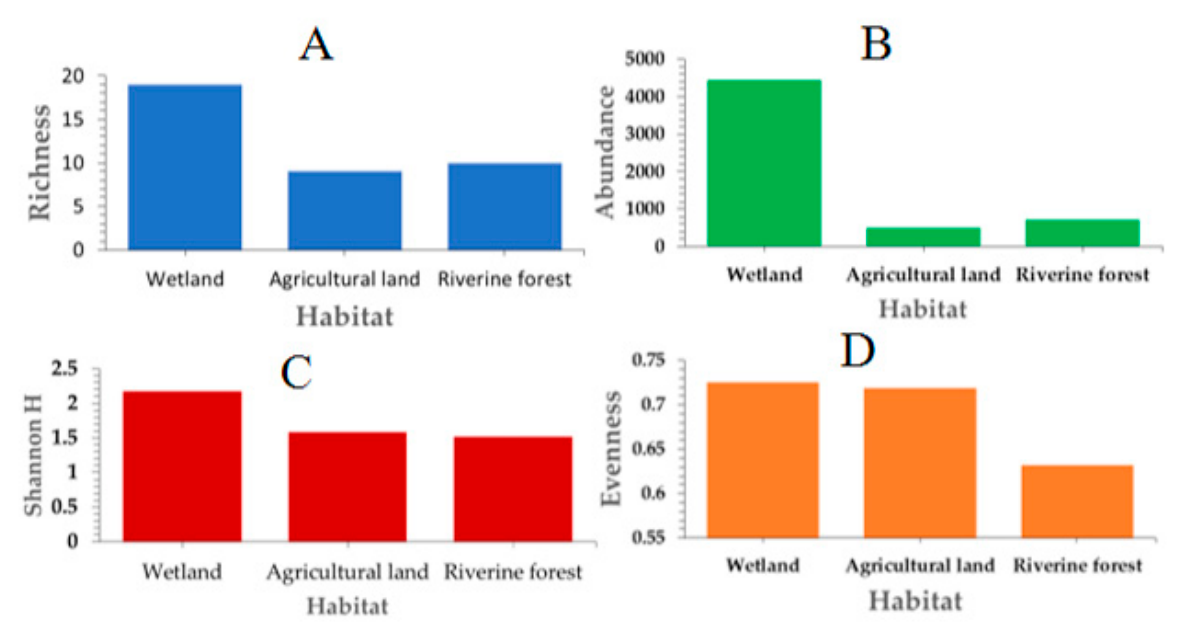
Figure 6. The diversity variation of anuran species among habitats in the Keffa area: ( A ) richness; ( B ) abundance; ( C ) Shannon H diversity; and ( D ) evenness.